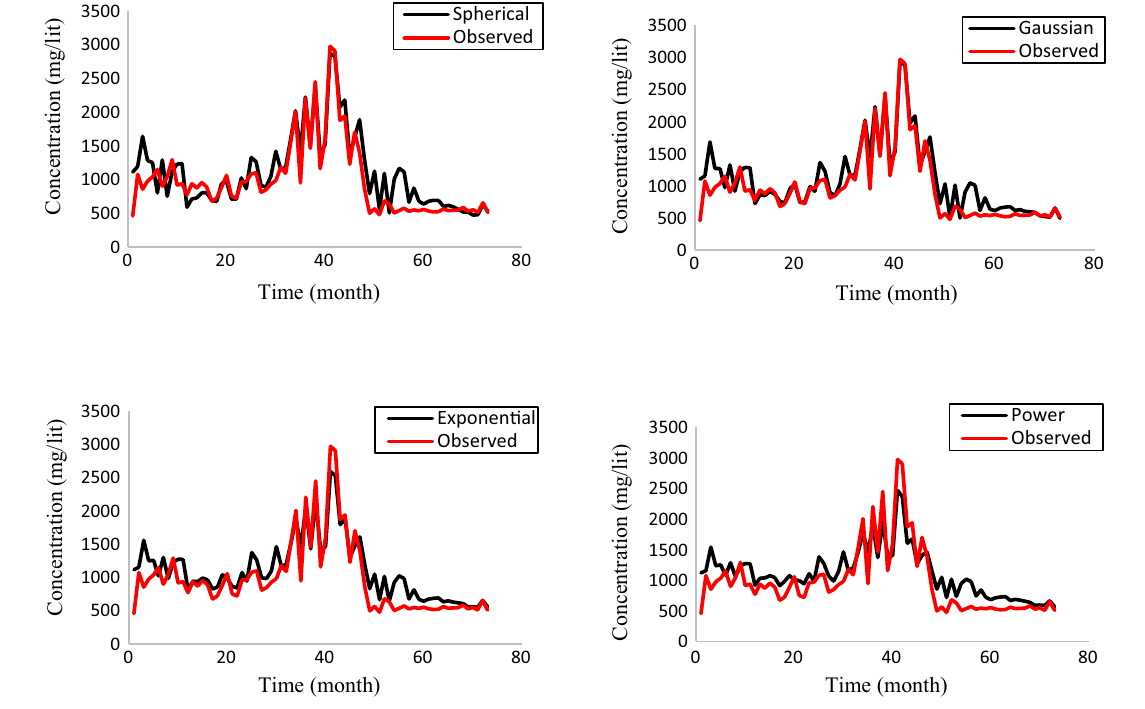
Fig. 9 Temporal variation of TDS in the obs. 2 for observed and predicted data